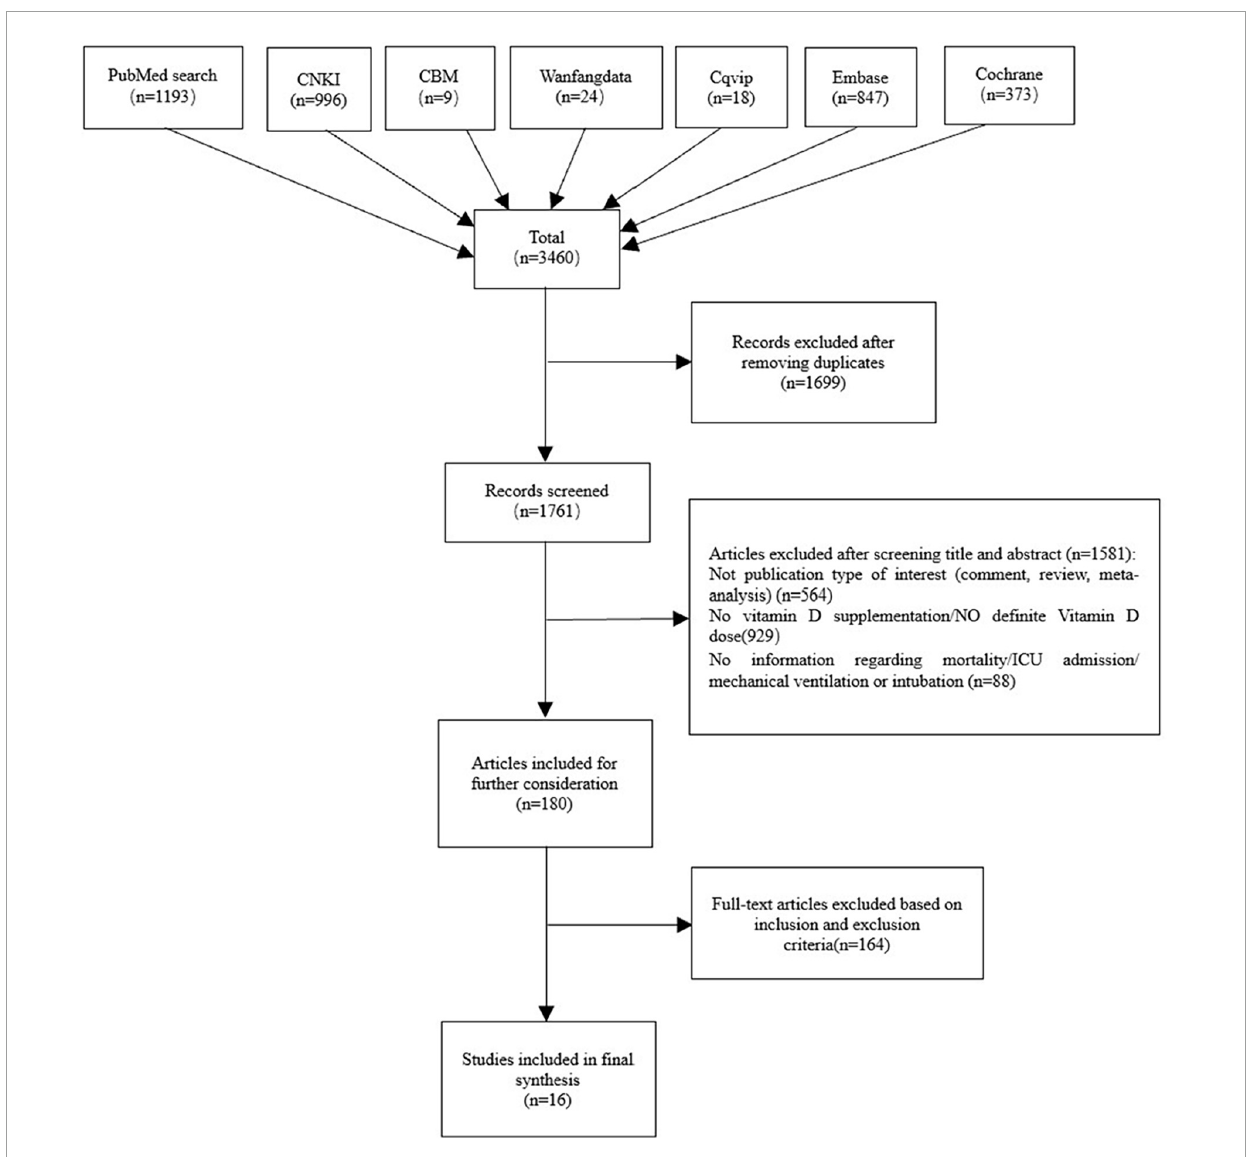
FIGURE1 Flow chart of literature searching and